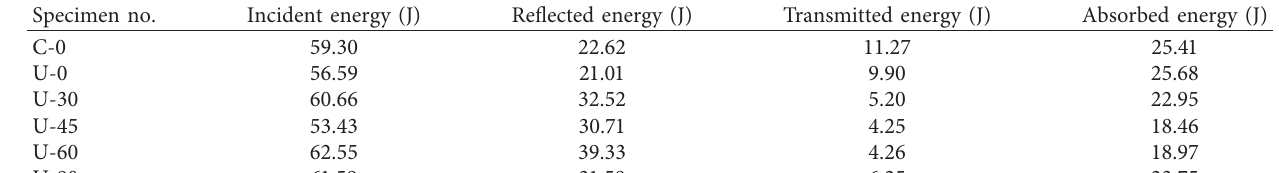
Table 7: Energy properties of flawed granite specimens under SHPB tests.